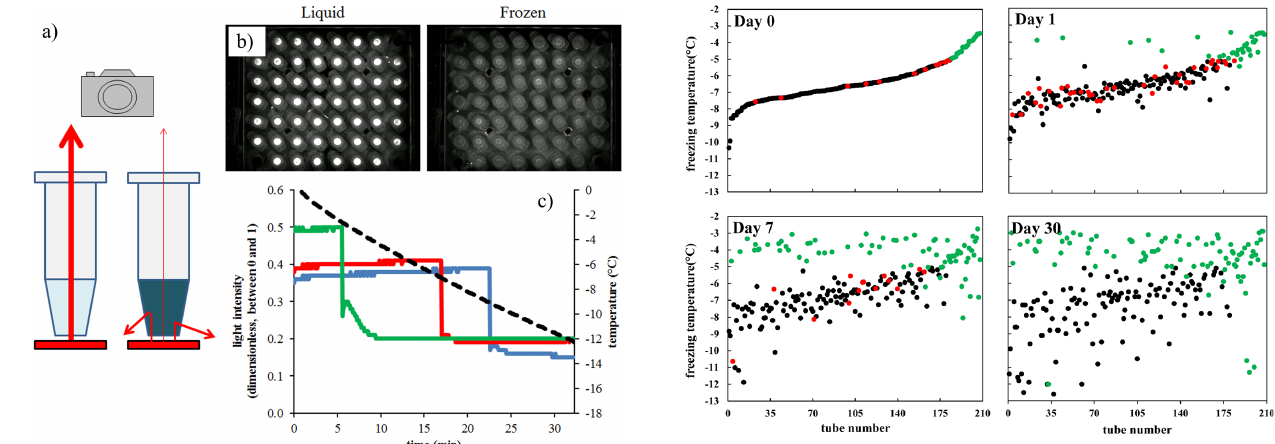
Fig. 3. (a) Schematic representation of the principle of freezing detection by a decrease in light transmission associated with the passage from liquid water (light blue) to ice (dark blue); (b) im- ages taken by the camera at the beginning and the end of a test run when all samples were liquid (left panel) and frozen (right panel); (c) time record of temperature (black dashed line) and light inten- sities of three tubes (coloured solid lines) showing the sudden and sharp decrease in recorded light intensity (full line), associated with ice nucleation. As shown in the graph, this system provides good detection of freezing events without loss of reliability also at tem- peratures close to 0 ◦ C, where visual detection may be more difficult (Vali, 1995).